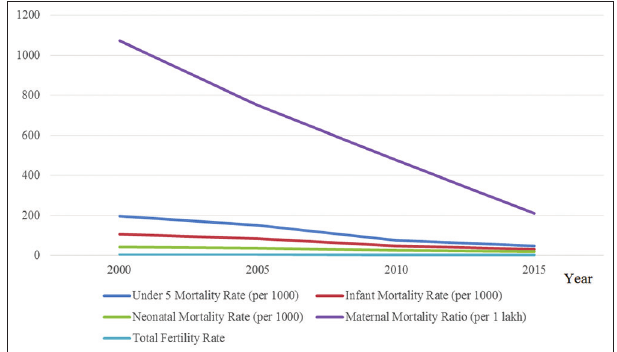
Figure 2 : Decline in Key Mortality indicators in Rwanda, 2000 to 2015; Source: Rwanda Demographic and Household Survey Reports